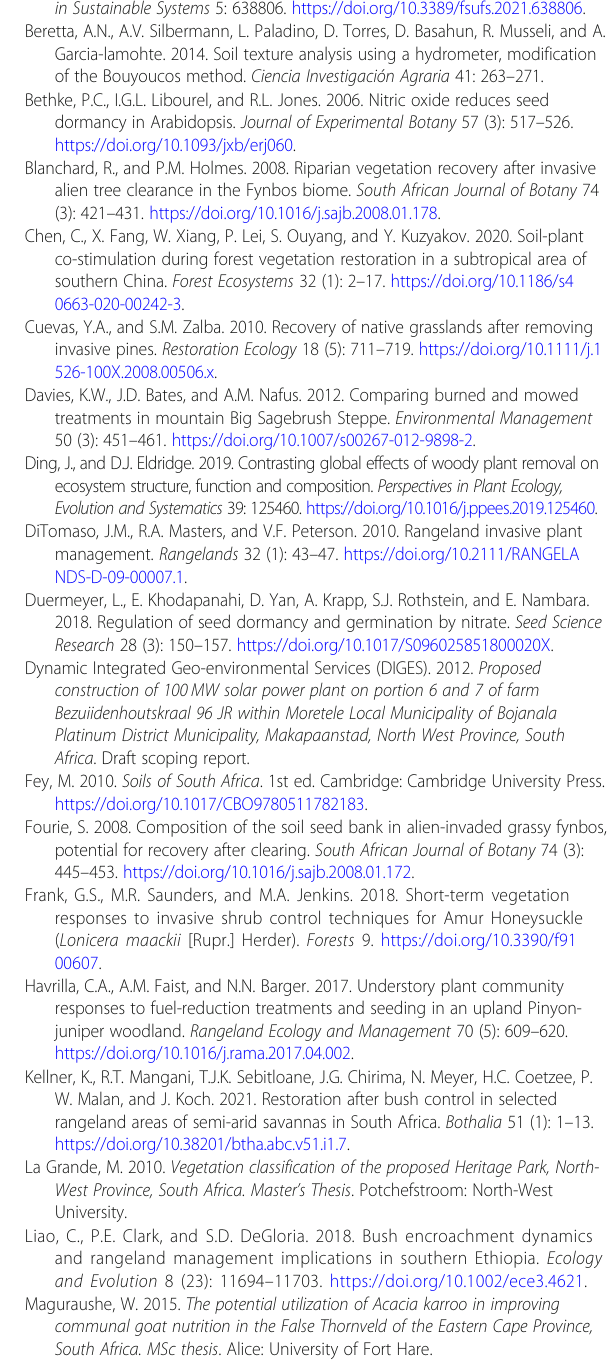
Additional file 1: Table S1. Pearson ’ s correlation between herbaceous species and soil properties at Makapaanstad